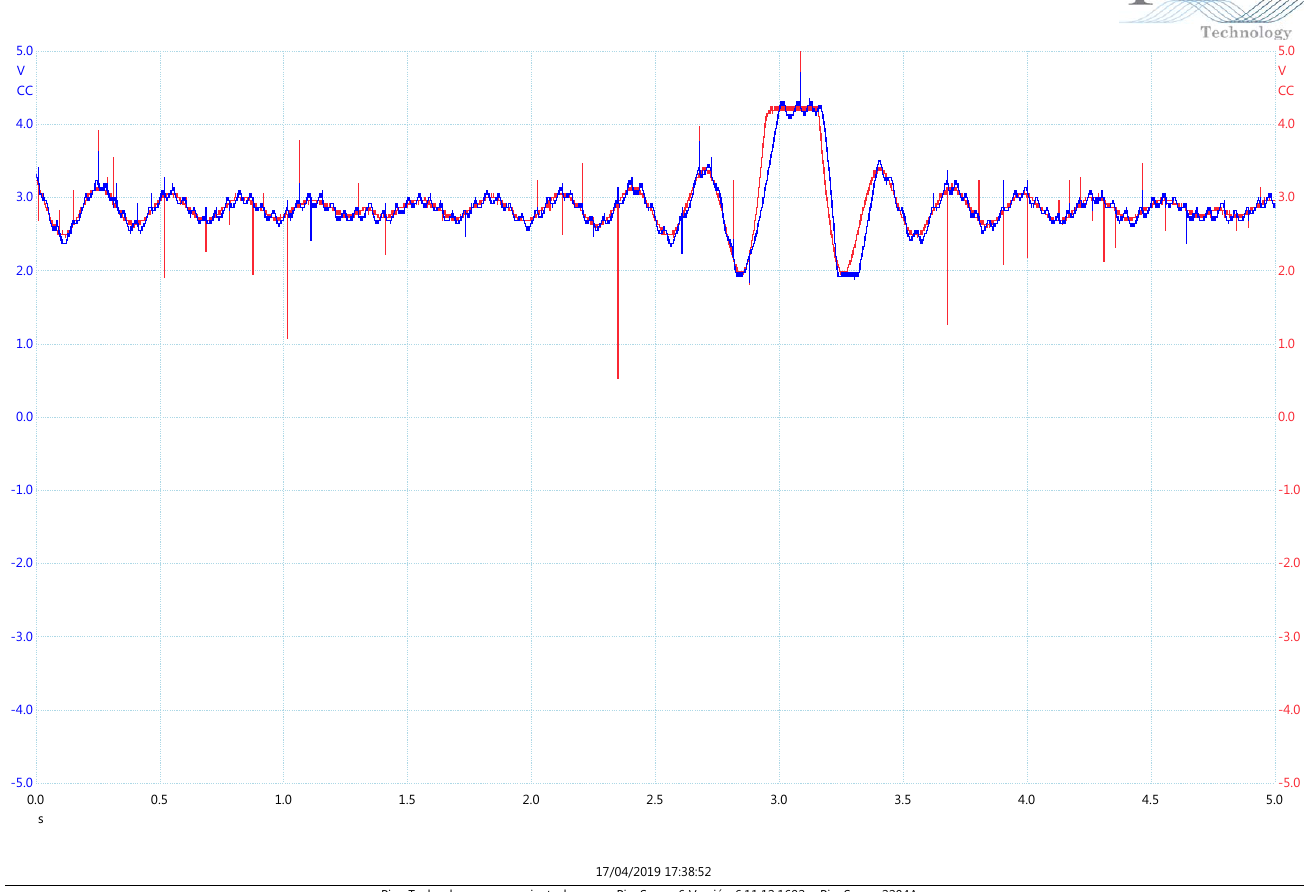
Figure 9. Experimental plots. The blue line is the measured throttle angular position and the red line is the desired reference route. In this case, the used reference corresponds to a class of a sinc function typically presented in signal processing by using the Fourier